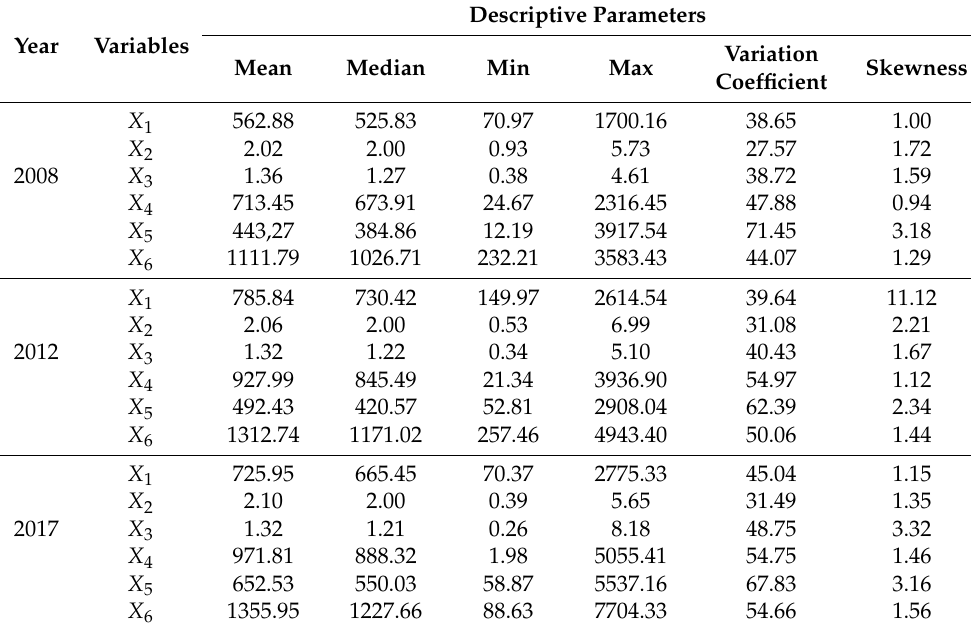
Table 3. Values of basic descriptive parameters of diagnostic features in 2008, 2012,